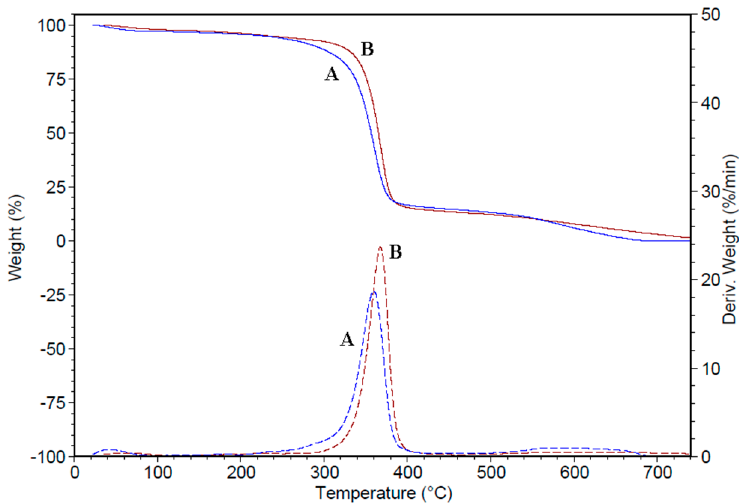
Figure 5. TGA-DSC curves of prepared membranes: CA/PEG ( A ) and CA/PEG/CHI-Ag ( B ).